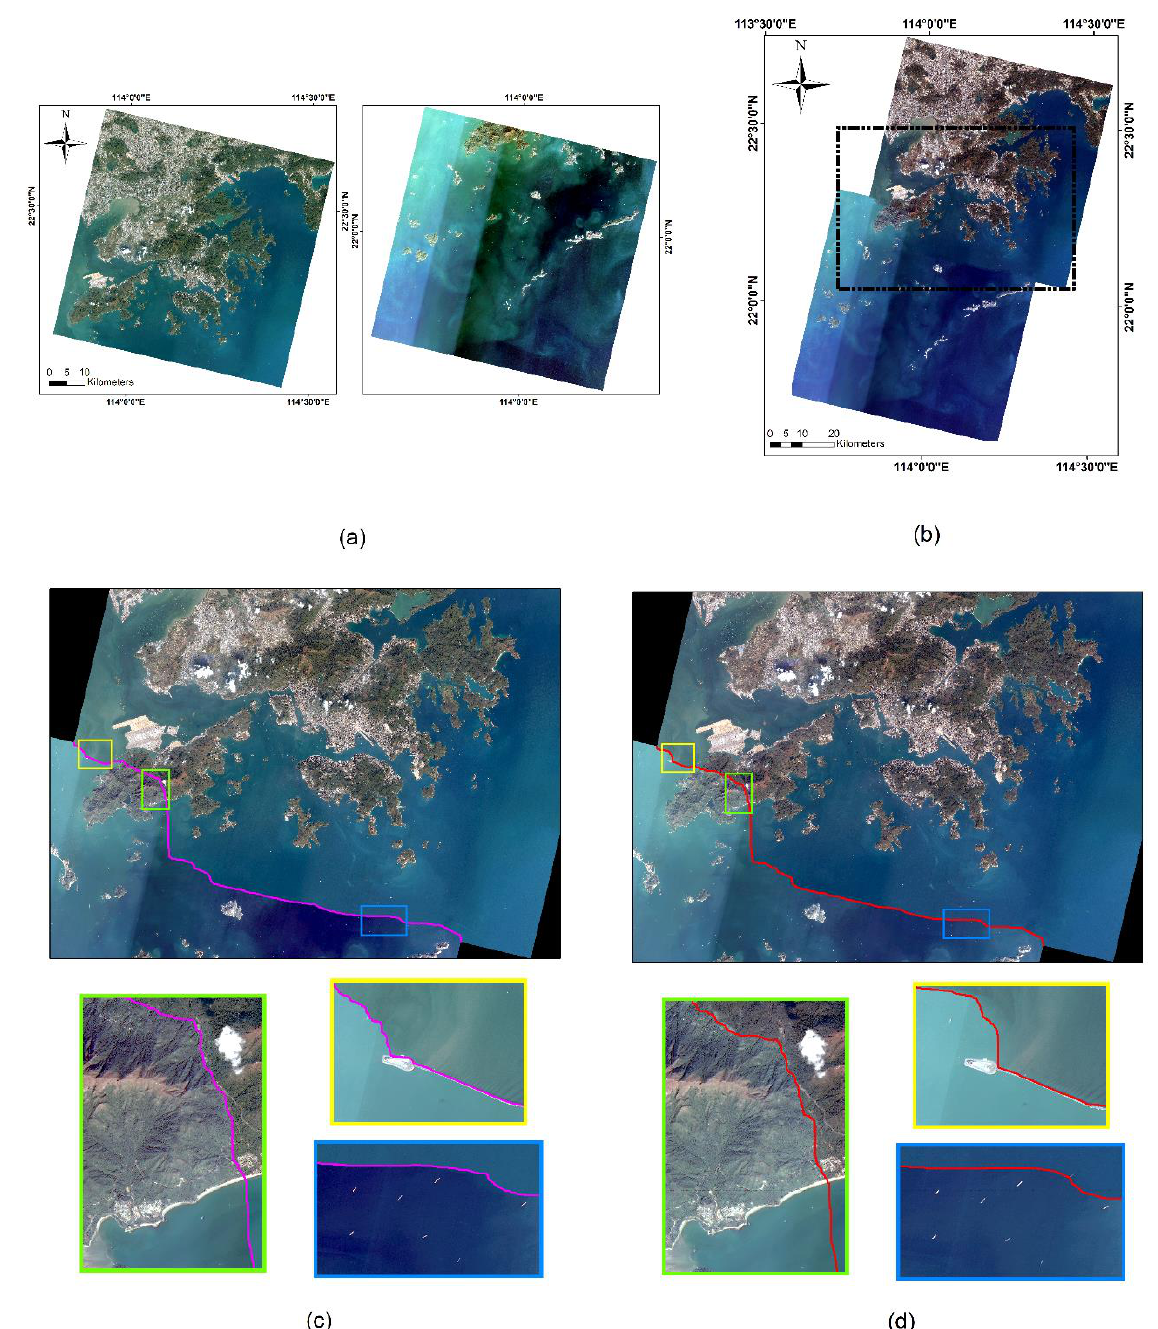
Figure 11. Comparison of the seamlines on Dataset 4: ( a ) original large remote sensing images; the stitching result obtained by ( b ) our method; ( c ) Resample+ Dijkstra; and ( d ) ours. Three locations are selected to show the refinement differences of the seamlines obtained by different algorithms with rectangular boxes of different colors. The colored line in the image is seamlines.